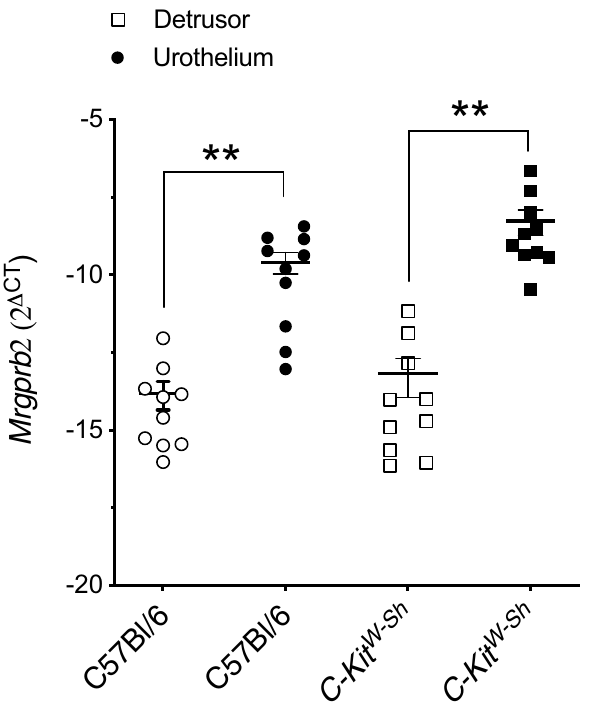
Figure 2. Isolated bladder tissue from both wild-type and mast cell-deficient mice express Mrgprb2 mRNA. Mrgprb2 mRNA expression in the urinary bladder smooth muscle layer and urothelial layer from both C57Bl/6 (N = 10) and C-Kit W-Sh mice (N = 10), as measured by qRT-PCR. Both mouse models express Mrgprb2 in the bladder in both layers and to a similar extent [ P = 0.442 and P = 0.0555 for detrusor and urothelium respectively (C57Bl/6 vs. C-Kit W-Sh )]. Mrgprb2 mRNA expression in the urothelium is significantly higher in both mouse models [( P = 0.0028 and P = 0.0061 for C57Bl/6 and C-Kit W-Sh respectively (Detrusor vs. Urothelium)]. Data shown as Mrgprb2 expression relative to the housekeeping gene,